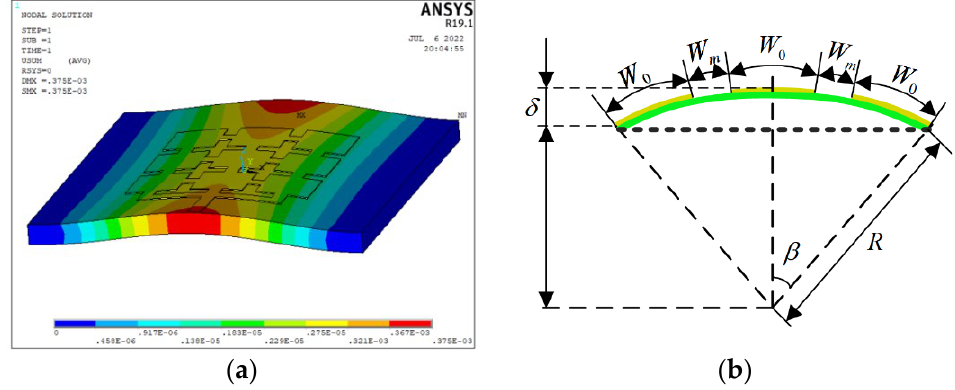
Figure 10. ( a ) Reconfigurable microstrip antenna deformation at an ambient temperature of 120 °C; ( b ) schematic diagram of the bending deformation of the reconfigurable antenna element.